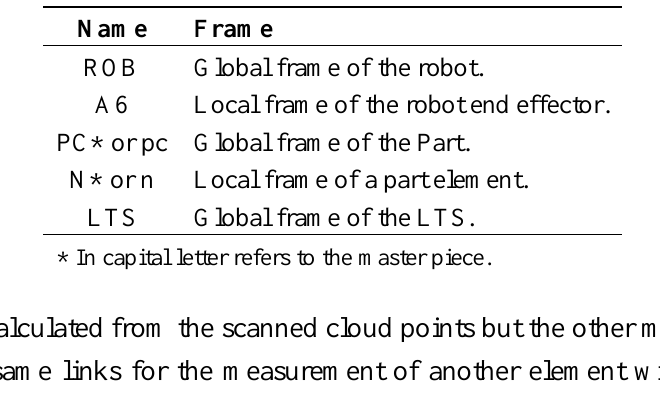
Table 5. Principal frames used in the proposed